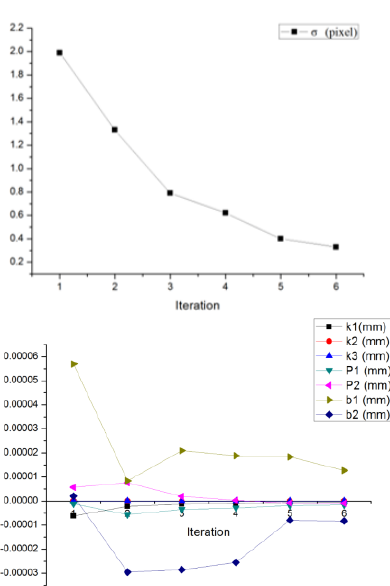
Figure 3. Changes of σ and planimetric distortion coefficients of Trial A .